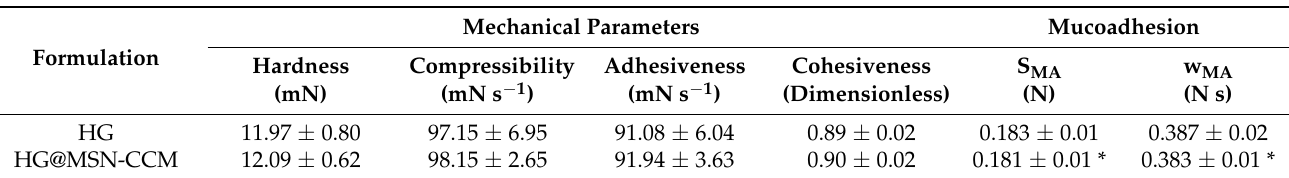
Table 3. Mechanical and mucoadhesion properties of the HG and HG@MSN-CCM. The values are shown as mean ± standard